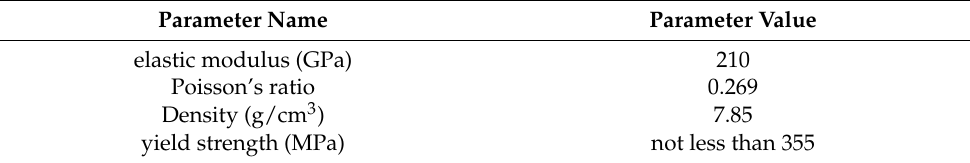
Table 5. 45# Steel material parameters.